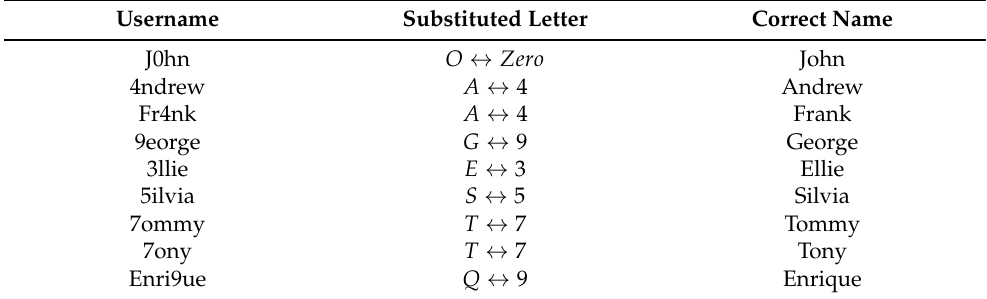
Table 4. A sample of usernames that have numerical substitution and the equivalent correct